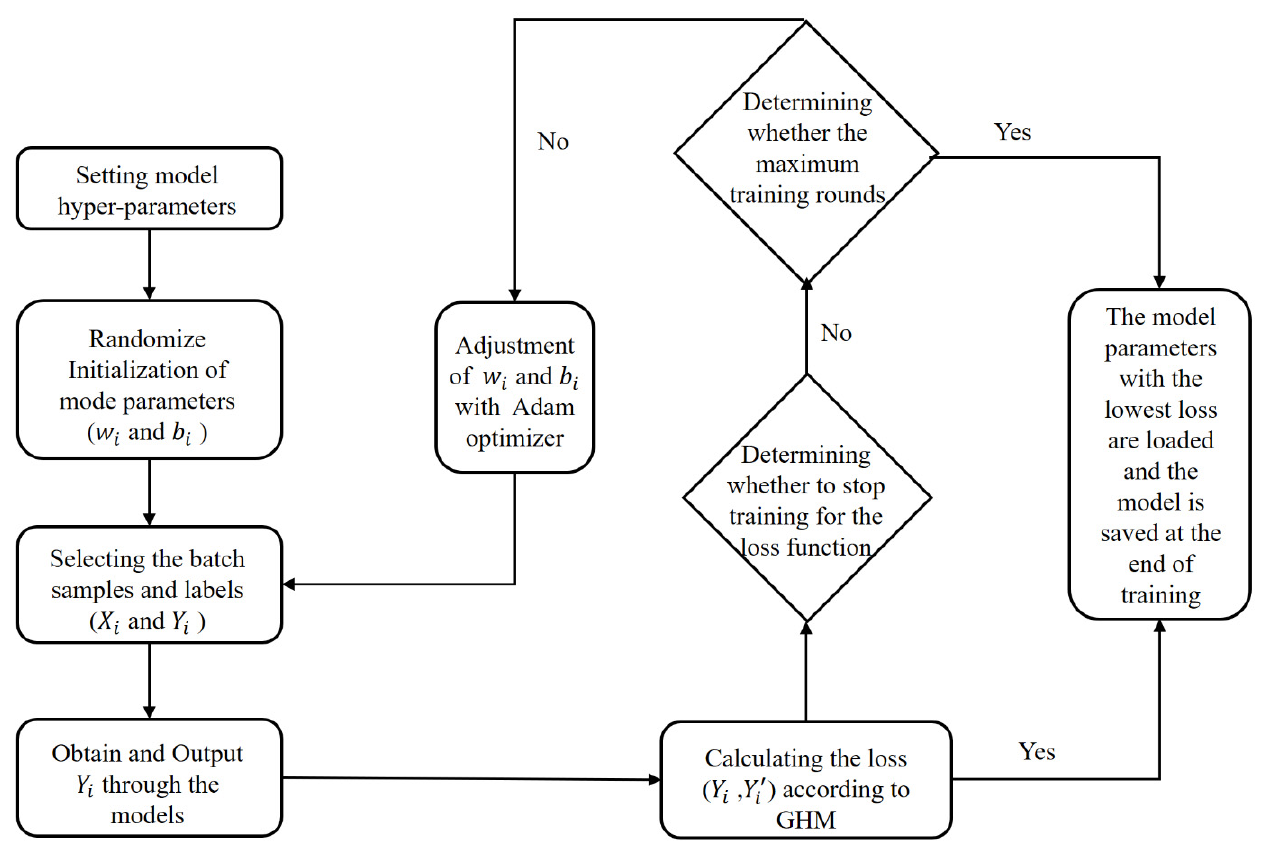
Figure 4. Training workflow of the Lightning-SN network model.